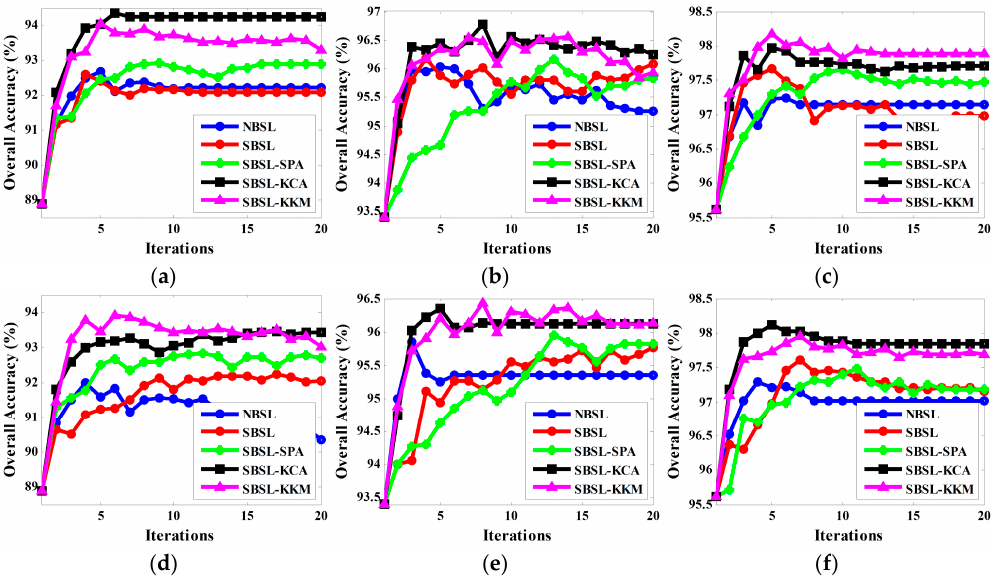
Figure 6. Overall accuracies (as a function of AL iteration) obtained for the data set of the University of Houston. ( a ) 5 labeled samples, MBT; ( b ) 10 labeled samples, MBT; ( c ) 15 labeled samples, MBT; ( d ) 5 labeled samples, MMS; ( e ) 10 labeled samples, MMS; ( f ) 15 labeled samples, MMS. The three